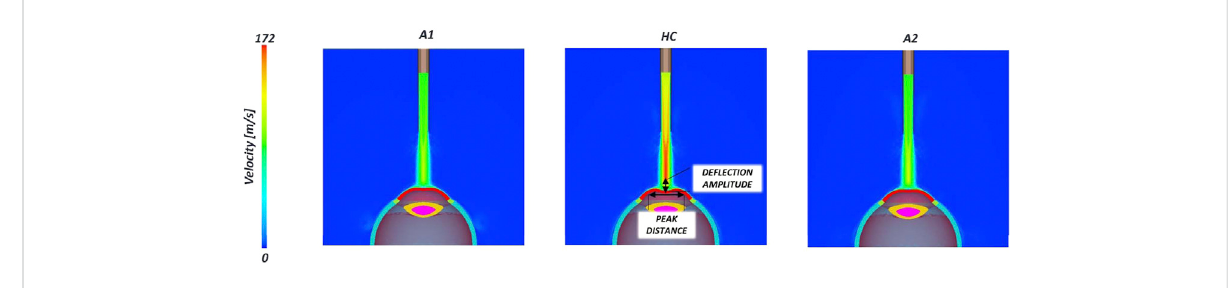
FIGURE 6 Air velocity contour in three-time points (A1, HC and A2) during the air-puff. In the instant of highest concavity two biomarkers (peak distance and de fl ection amplitude) are highlighted.